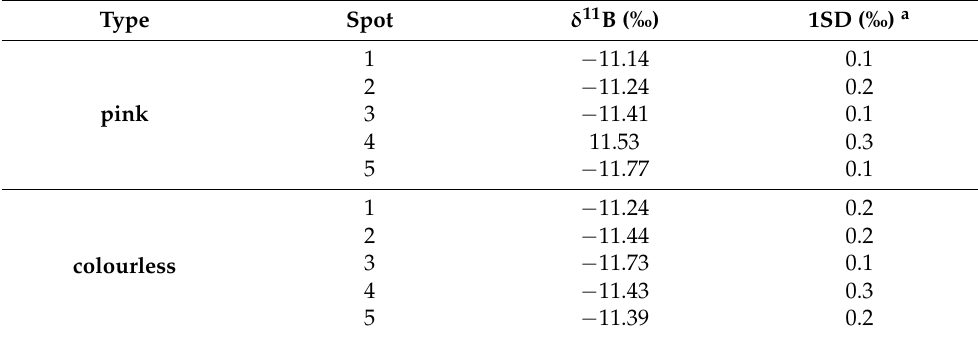
Table 3. Boron isotope compositions (given as δ 11 B values) of tourmalines from pink part to colourless part.